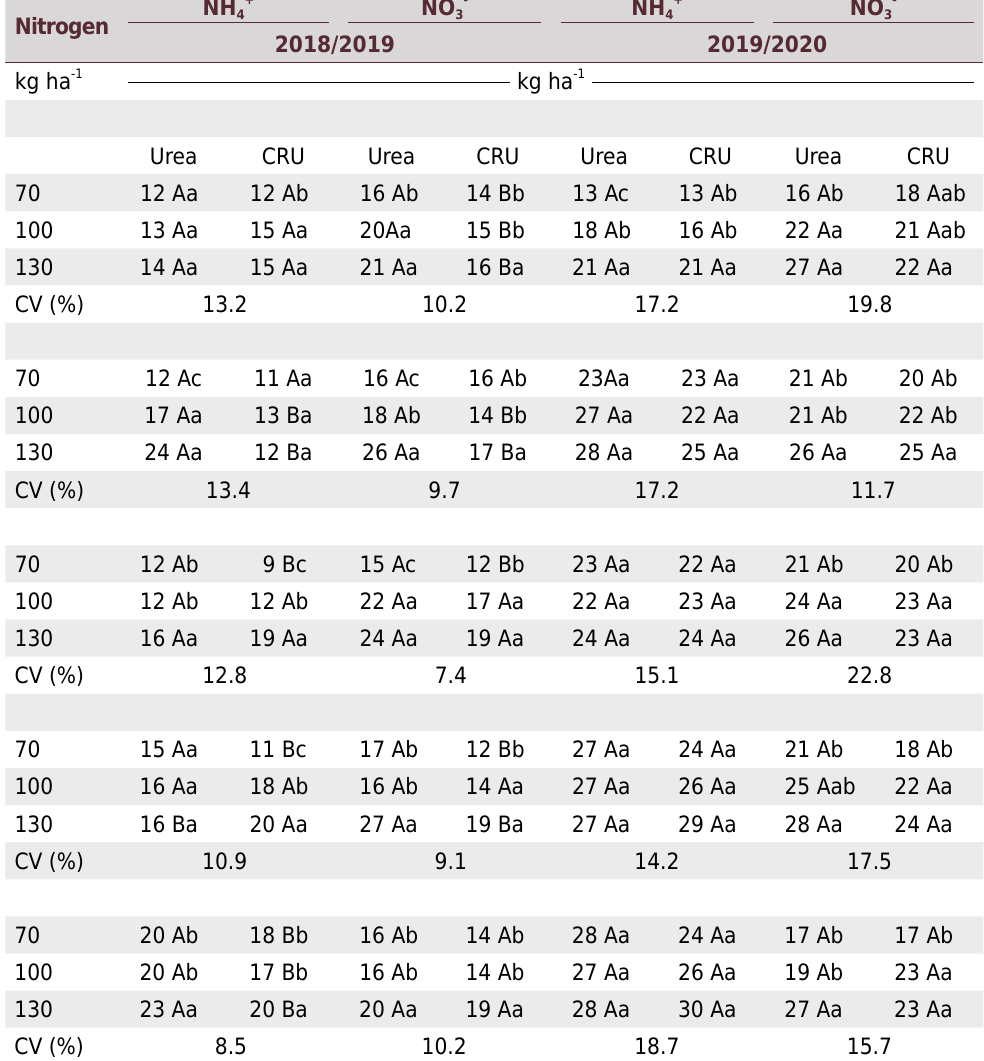
Table 2. Stock of ammonium and nitrate in the soil (0.00-0.20 m) during the cotton flowering period